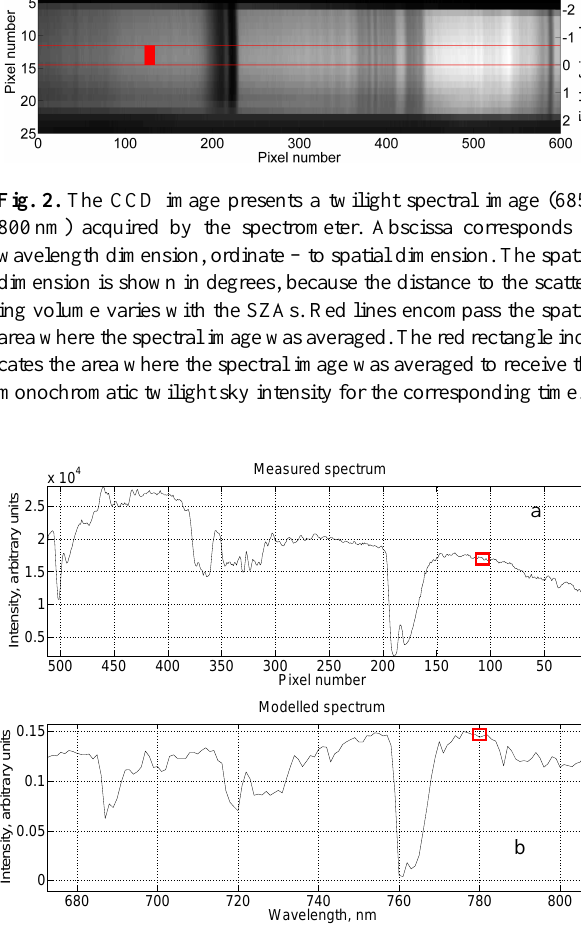
Fig. 3. An example of the measured (a) and the modelled (b) twi- light spectrum. The red rectangles indicate the averaging area. Many atmospheric absorption bands in this spectral range are avail- able for use in wavelength